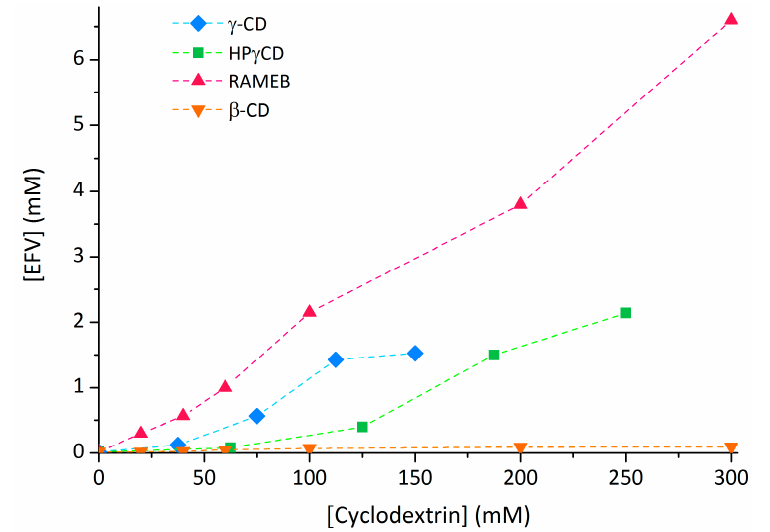
Figure 4. Comparison of the solubility isotherms of efavirenz (EFV) with different cyclodextrins. Adapted from literature reports on EFV with β -CD and RAMEB [56]; γ -CD and HP γ CD [54]. Within these hosts, RAMEB appears to be the most effective solubiliser for efavirenz, followed by γ -CD (albeit this host showed a solubilisation plateau above 112.5 mM). β -CD was the least effective, having a very small effect on the solubility of